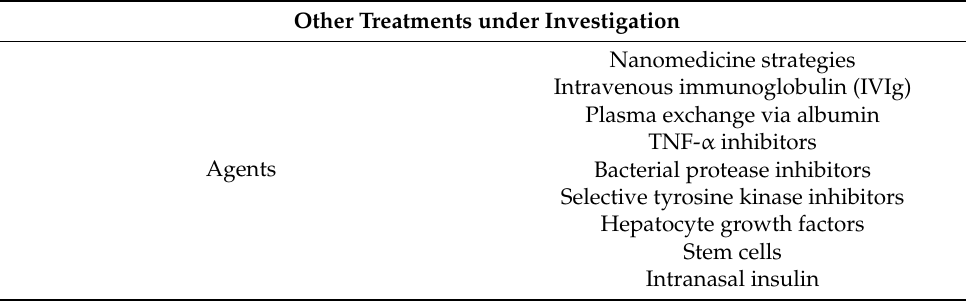
Table 3. Other treatments under